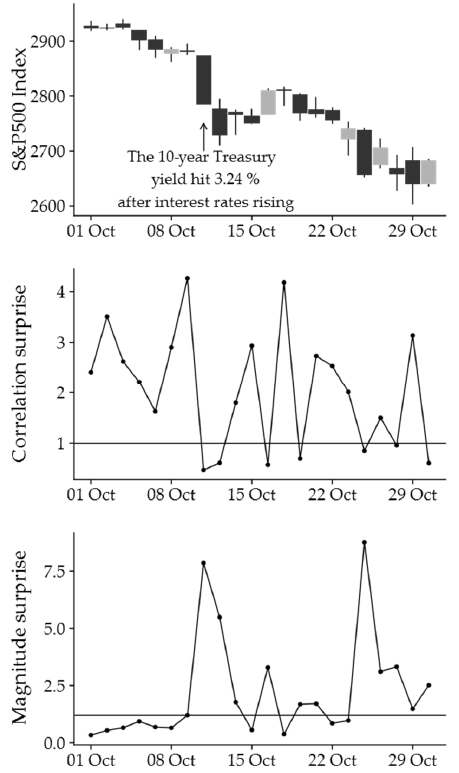
Figure 5. Analysis of the financial turbulence, October 2018.